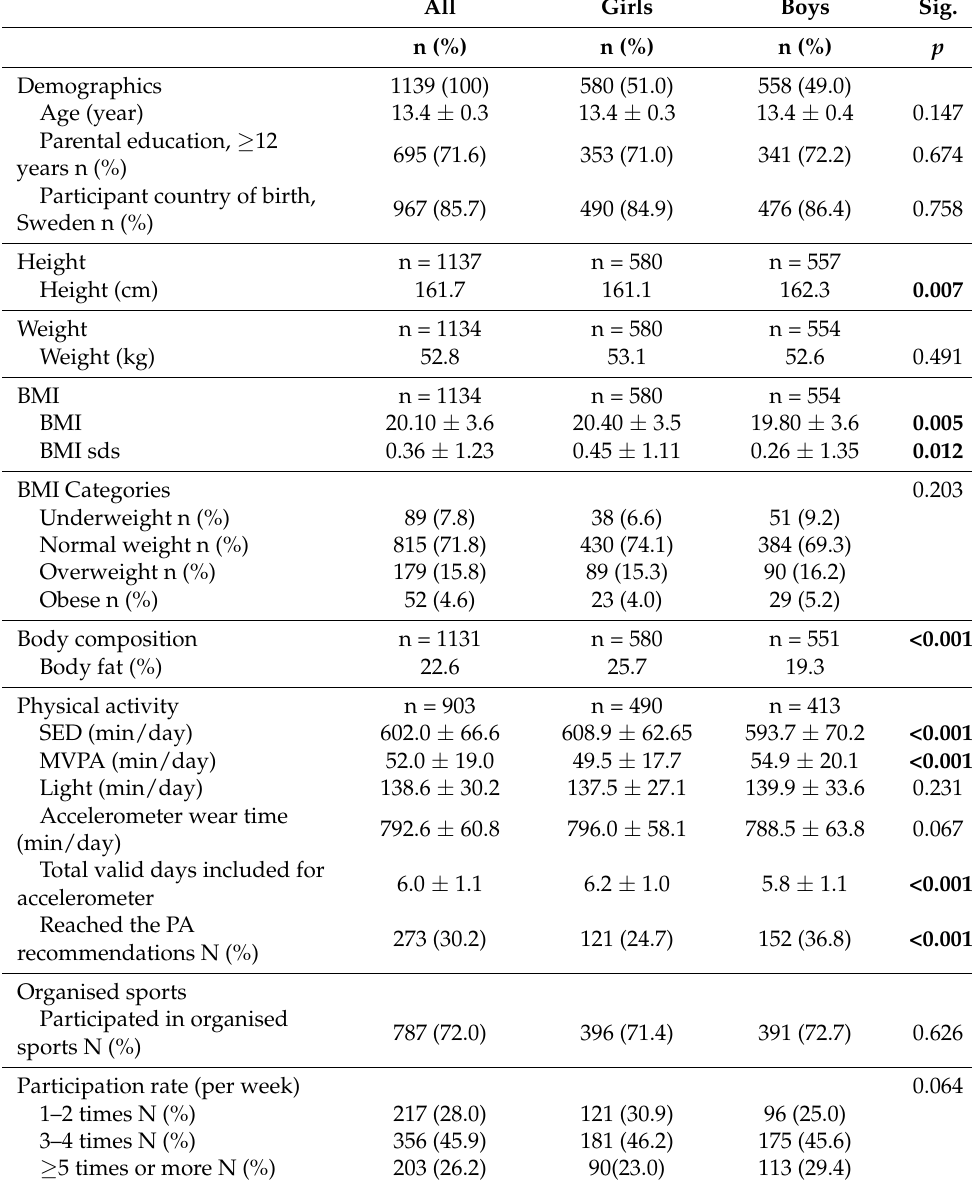
Table 1. Descriptive characteristics of the study sample by sex (mean ± SD unless otherwise speci-